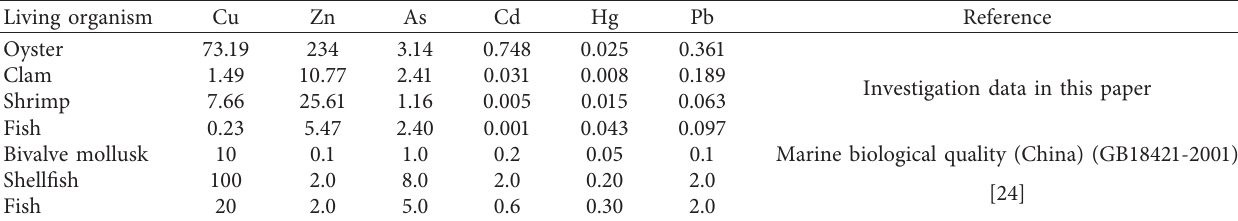
Table 11: Heavy metal contents in various living organisms in Jiuzhen Bay ( μ g/g ww).